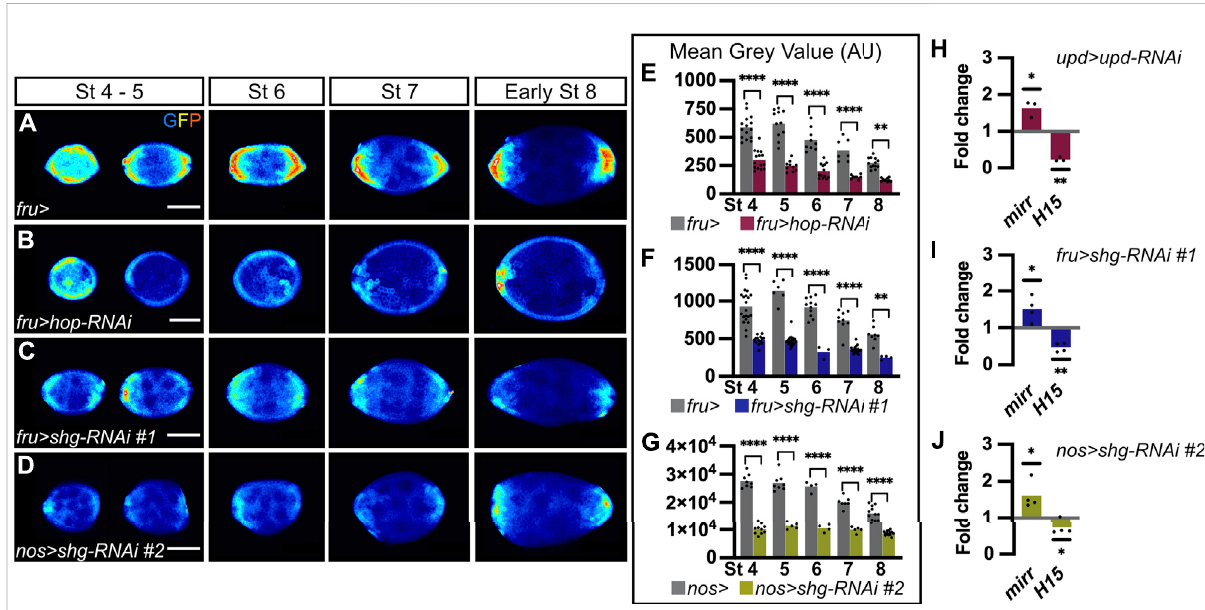
FIGURE 3 E-cadherin is a positive regulator of JAK-STAT signaling. In all images, the anterior is to the left. (A – D) Follicles at various stages of oogenesis from 10XSTAT92E-GFP hemizygous females in four different genetic backgrounds. GFP immunostaining ( “ royal ” fi lter, sum projection of total GFP signal)re fl ectsJAK-STATactivityateachpole. (A) Folliclesfromfemalescarryingthe fru-Gal4 driverareusedasacontroltoassessJAK-STATactivity, whichformsagradientinfolliclecells(FCs)ateachpolethroughoutoogenesis. (B) FolliclesfromfemalesexpressingaRNAitargeting hop inFCs driven by fru-Gal4 to decrease JAK-STAT signaling, as illustrated by weak GFP signal at each pole from stage 4 onward. Follicles from females expressing the RNAi line #1 targeting shg driven by fru-Gal4 in FCs (C) or the RNAi line #2 also targeting shg but driven in germ cells (GCs) by nos - Gal4 (D) . In both knock-down conditions, GFP signal is low in the entire follicular epithelium from stage 4 onward. (E – G) Mean Grey Value quanti fi cations of entire follicles at various stages of oogenesis. In graphs, bars represent mean measurements and each dot corresponds to